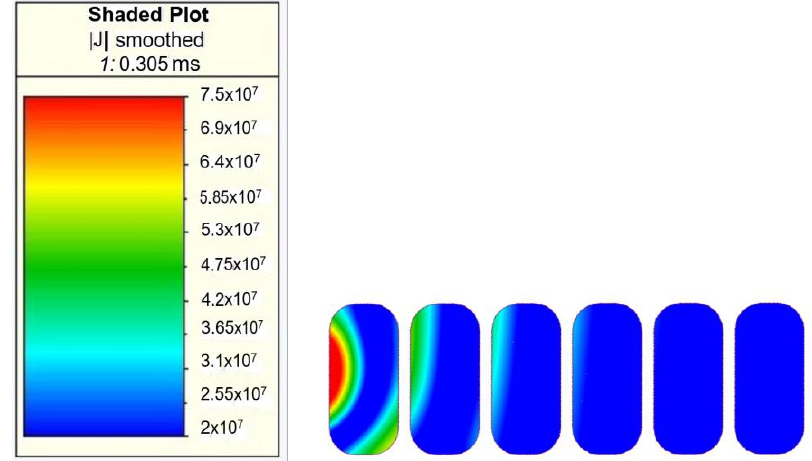
Figure 1. A general example showing the uneven current density distribution in hairpin conductors at high-frequency operations.